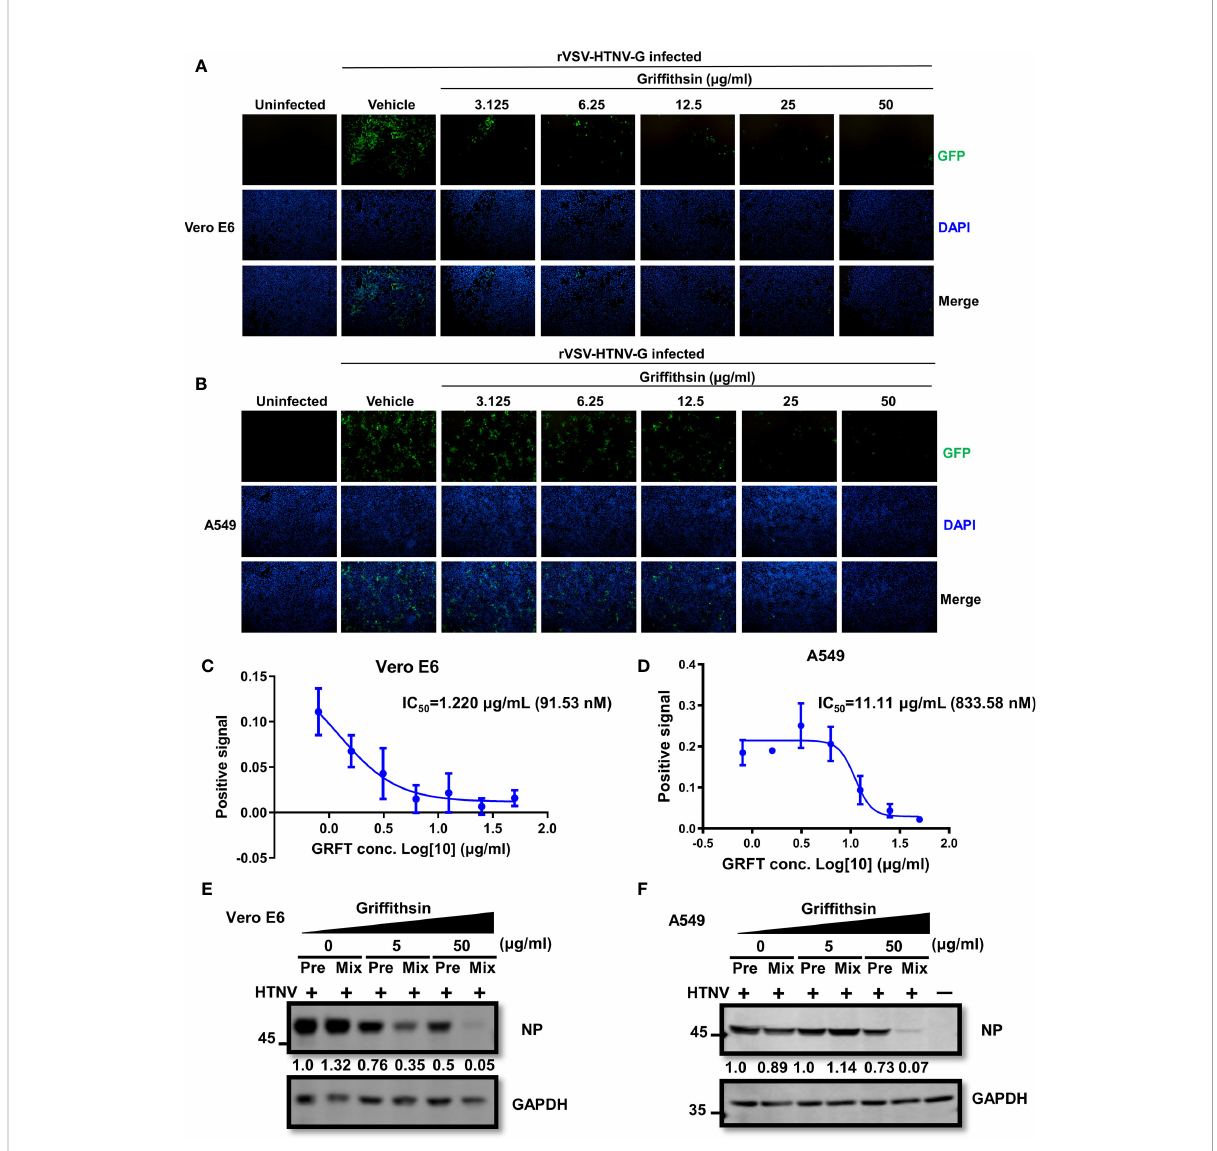
FIGURE 4 GRFT-pretreated cells reduce rVSV-HTNV-GFP and HTNV infection. (A, B) Vero-E6 cells (A) or A549 cells (B) were treated for 1 h with varying concentrations of GRFT and removed before being infected with rVSV-HTNV-G at an MOI of 1. At 24 h post-infection (hpi), the cell nuclei were stained with Hoechst 33258 and viewed under an inverted fl uorescence microscope. Green, GFP, indicating the replication of rVSV-HTNV-G; blue, cell nuclei. (C, D) The quantitation of GFP-positive Vero-E6 (C) or A549 (D) cells after GRFT pretreatment of cells and infection with rVSV-HTNV-G (% normalized to the vehicle-only control) are shown in the dose – response curve. (E, F) The effects of GRFT antagonized HTNV infection in GRFT- pretreated cell group (Pre), or GRFT-treated virus group (Mix). Vero E6 (E) and A549 (F) cells were pretreated with 5 or 50 m g/ml of GRFT or vehicle and then infected with HTNV (MOI = 1), or equivalent HTNV was treated with 5 or 50 m g/ml of GRFT or vehicle for 1 h, and then the mixture was used to infect Vero E6 and A549 cells. At 72 hpi, the NP level within the cell was detected and normalized to GAPDH level. Data shown in the graphs are presented as the mean ± SDs and are representative of three independent experiments performed in triplicate. GRFT, grif fi thsin; rVSV, recombinant vesicular stomatitis virus; HTNV, Hantaan virus; MOI, multiplicity of infection; GFP, green fl uorescent